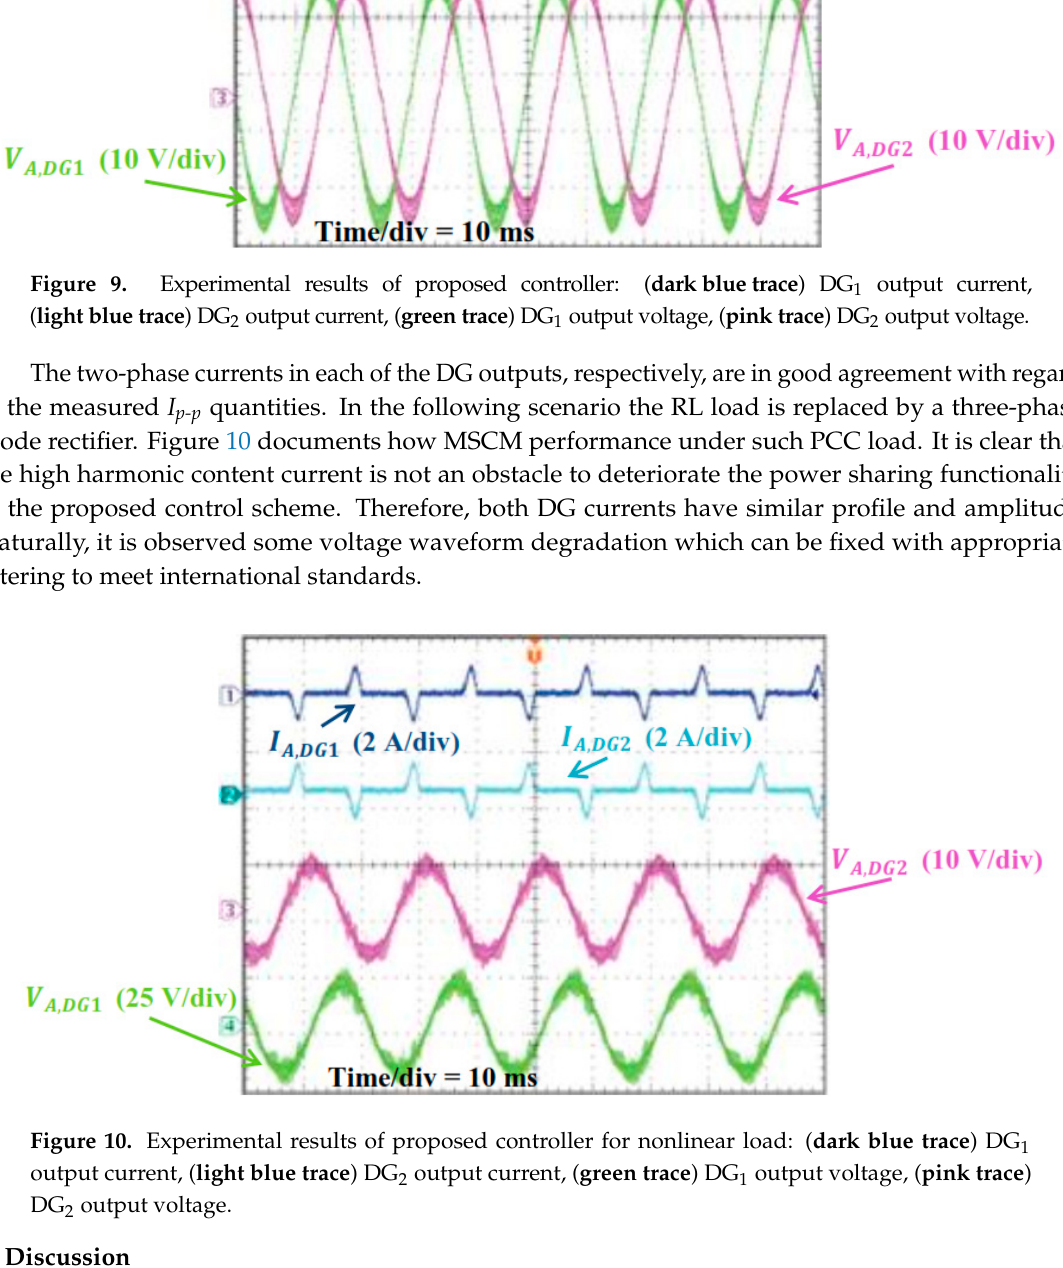
Figure 8. Experimental results of droop controller: ( dark blue trace ) DG 1 output current, ( light blue